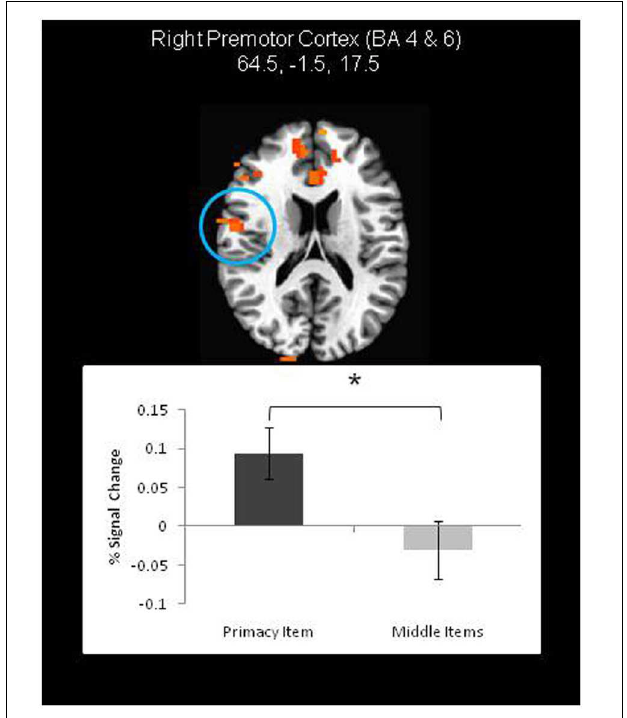
FIGURE 4 | A frontal lobe region exhibiting higher activation during primacy item trials than recency item trials during the retrieval period of a JOR task. In other words, a neural correlate of the behavior primacy effect. ∗ denotes significance at p < 0 . 05.